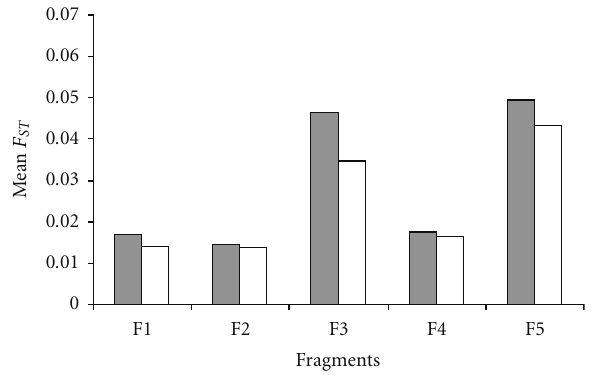
Figure 2: Degree of mean F ST values of each fragment in comparison with those of the remaining fragments. Solid and open bars represent degree of mean F ST values for fragments group without ecological corridors and considering both fragments and corridors,